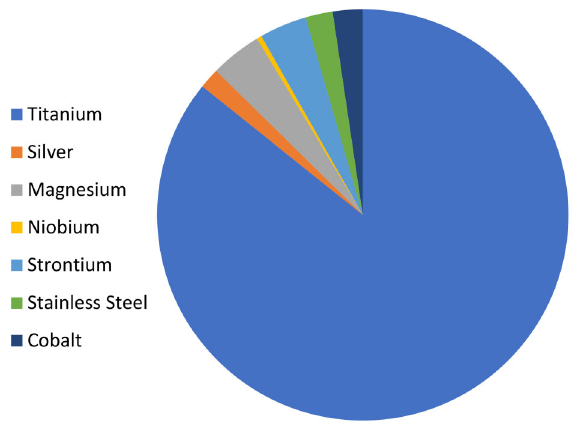
Figure 5. Graph showing metals distribution in publications retrieved from a search in the PubMed database using the following terms: ‘‘ Titanium ’’ , ‘‘ Silver ’’ , ‘‘ Magnesium ’’ , ‘‘ Niobium ’’ , ‘‘ Strontium ’’ , ‘‘ Stainless Steel ’’ and ‘‘ Cobalt ’’ . Each term has been associated with ‘‘ AND ‘‘ Bone Regeneration ’’ [MeSH]. June 1,